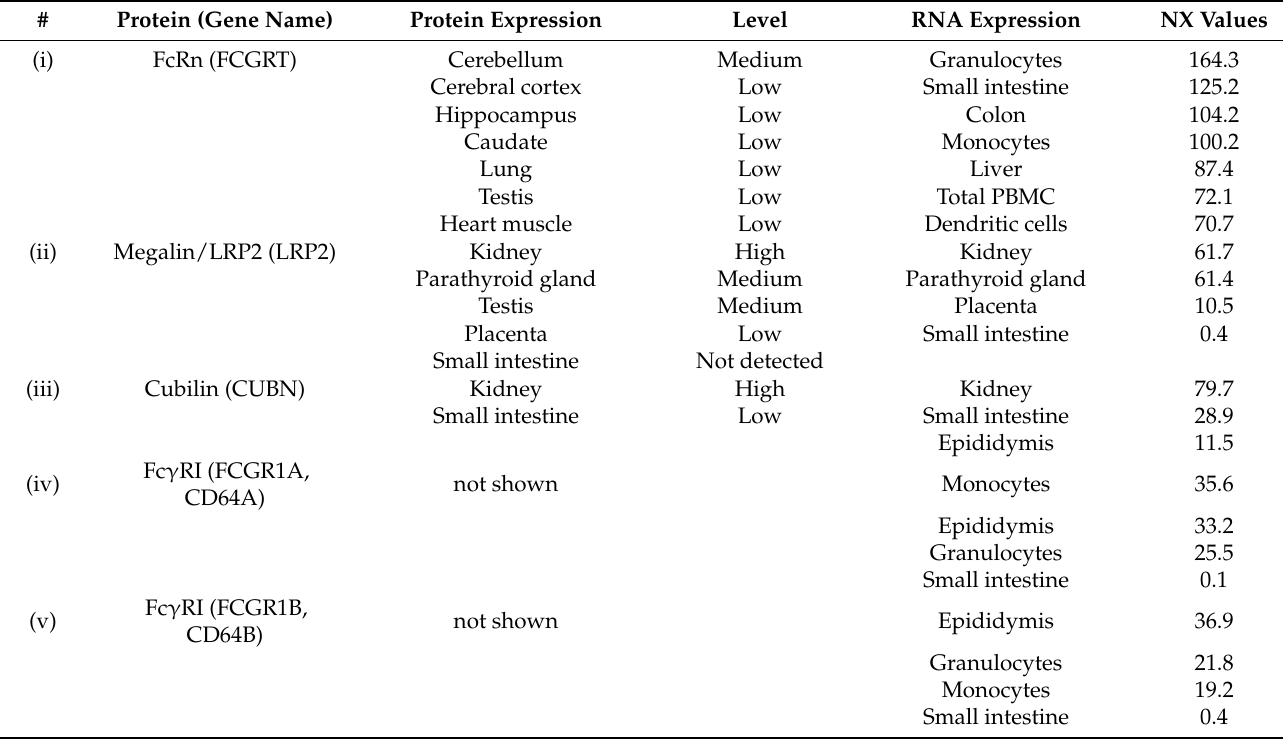
Table 2. Overview of protein and RNA expression of IgG-binding